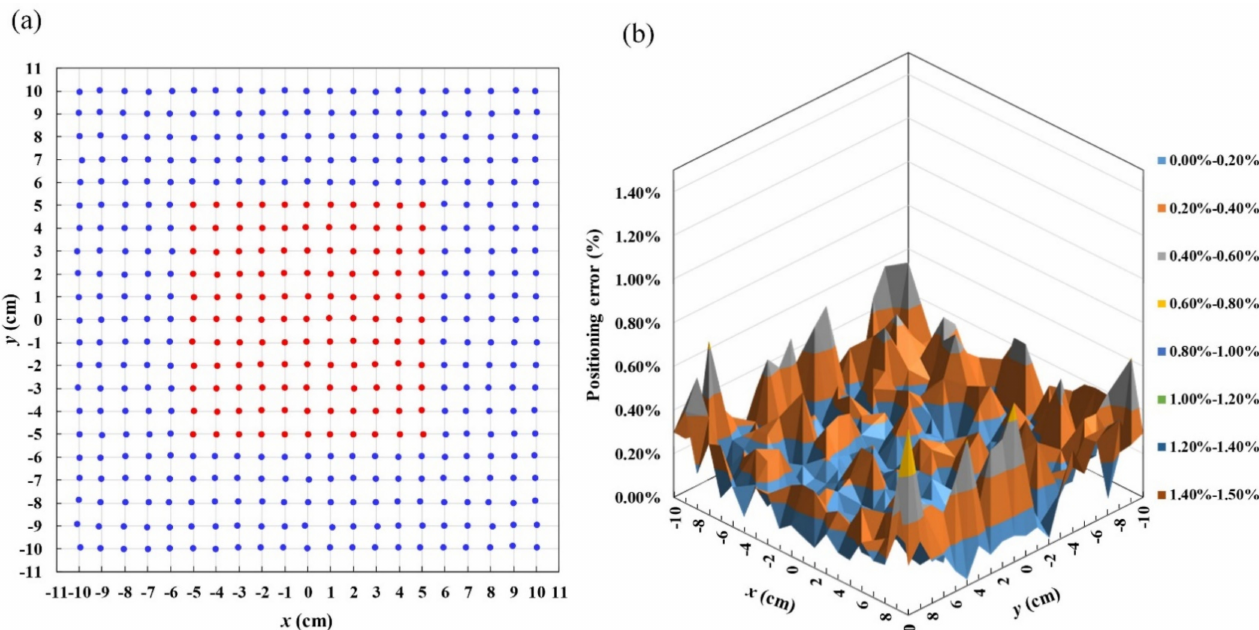
Figure 10. Retrieved coordinates and positioning errors of the 2D position-tracking system using an induction coil. ( a ) Retrieved 441 sensor positions in real time with grid size of 1 cm × 1 cm and ( b ) positioning error of tracking